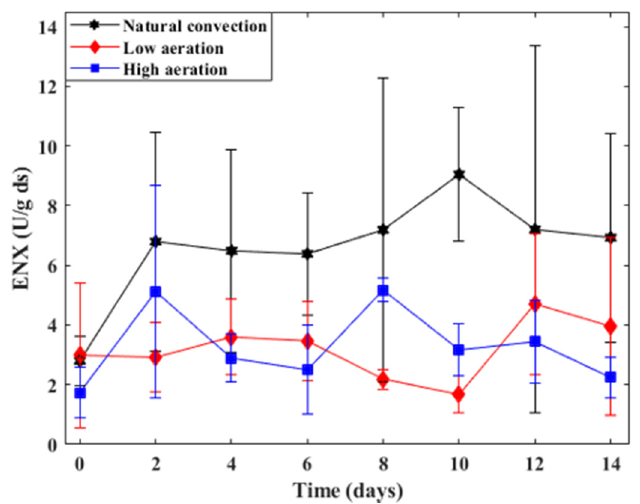
Figure 5. Time profile of β - D -1,4-xylanase (ENX) activity of T. versicolor cultivated in a fixed-bed pilot-scale bioreactor for 14 days of solid-state fermentation; ds: dry solid.